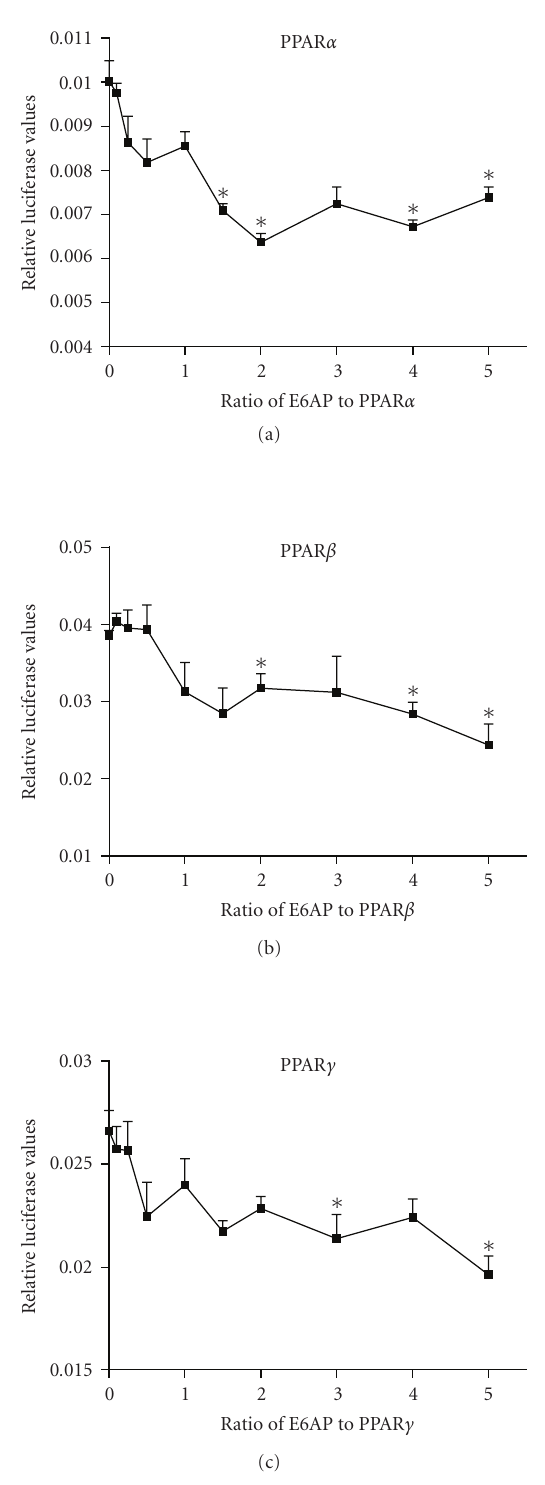
Figure 1: E6-AP inhibits the transcriptional activity of PPAR α , PPAR β , and PPAR γ . 293T cells were transfected with plas- mids expressing 4X-ACO-Luciferase, pRLCMV, PPAR α , PPAR β or PPAR γ , and E6-AP. Cells were lysed and luciferase activity was corrected for transfection e ffi ciency and protein. Asterisks indicate a significant di ff erence in luciferase values when compared to the 0 ratio group. ( ∗ P < . 05 with statistical analysis using ANOVA). The graphs are representative of 3 independent